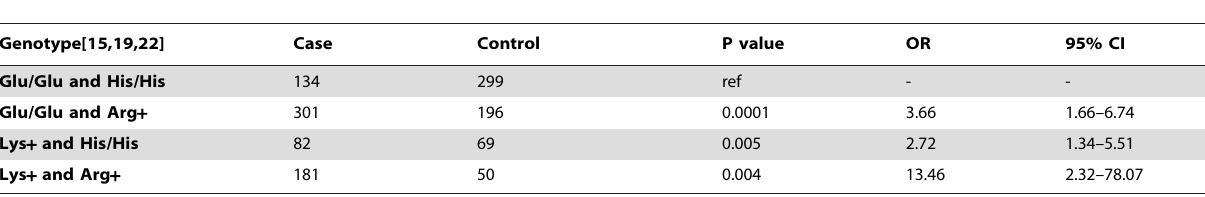
Table 3. Gene-gene interaction of ADH1B and ALDH2 on ESCC